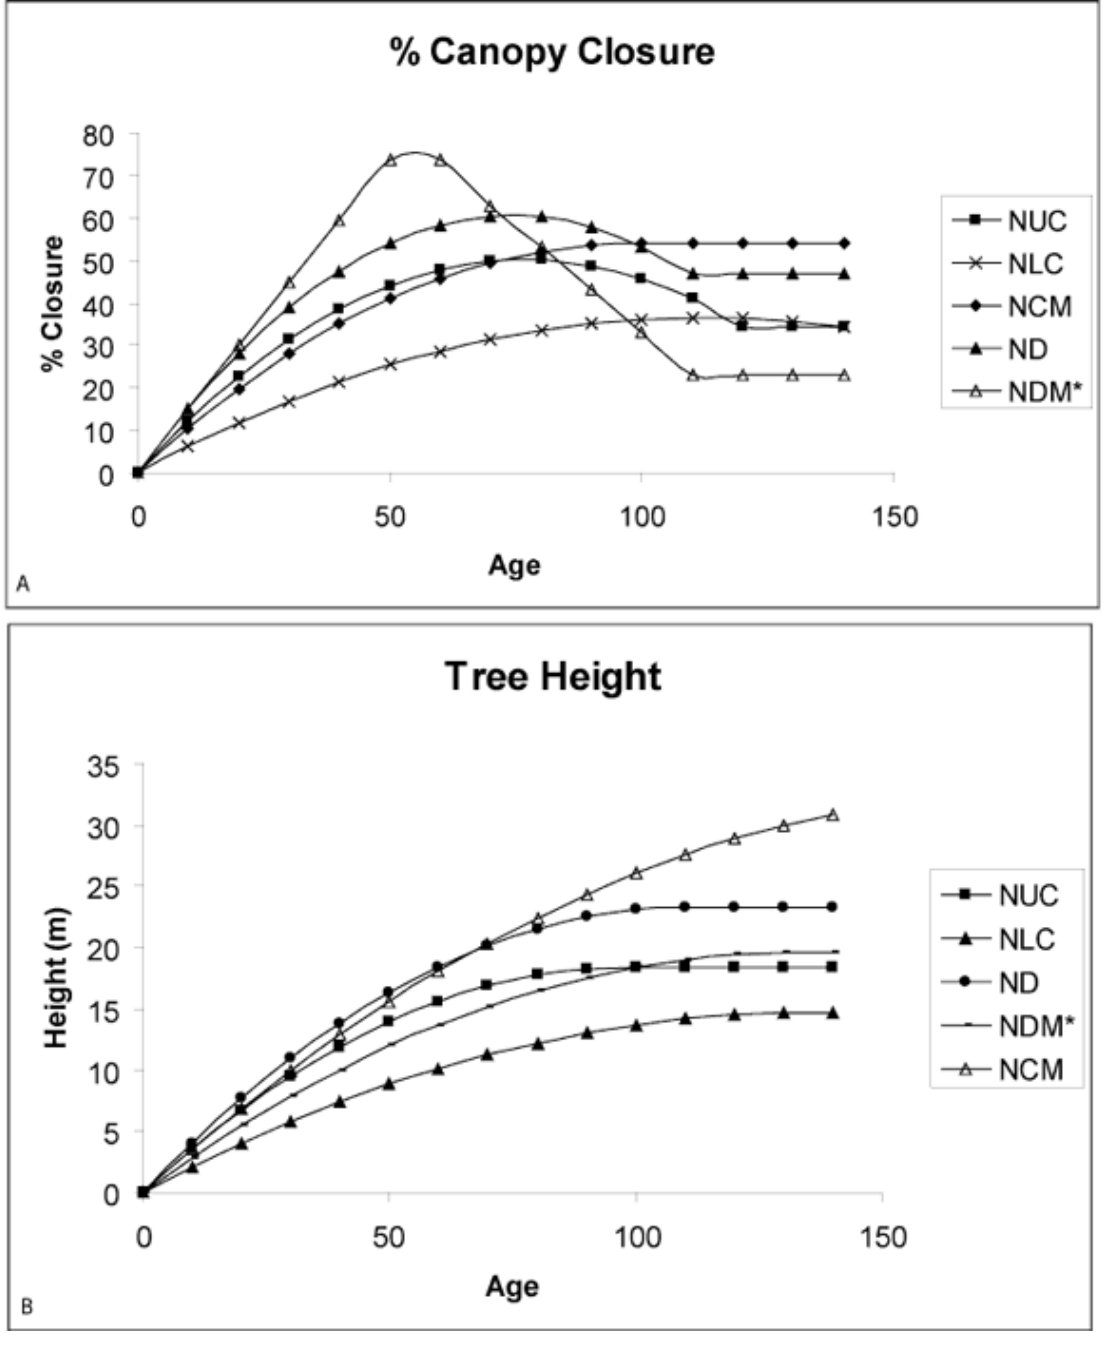
Fig. 6. Habitat element curves (HECs) for percent canopy closure and tree height (m) for northern upland conifer (NUC), northern lowland conifer (NLC), northern conifer mixed (NCM), northern deciduous (ND), and northern deciduous mixed